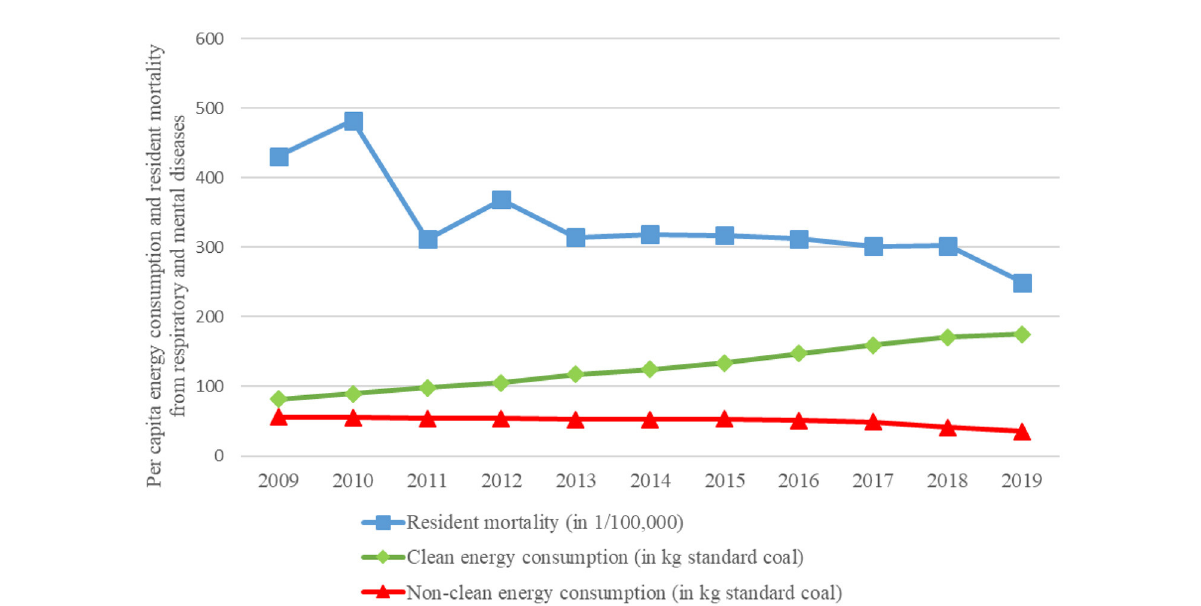
FIGURE1 Per capita energy consumption and resident mortality from respiratory and mental diseases of China. Data source: China National Statistical Yearbook (2010–2020). In this paper, the units of different energy sources are uniformly converted into kilograms of standard coal according to the energy calorie conversion